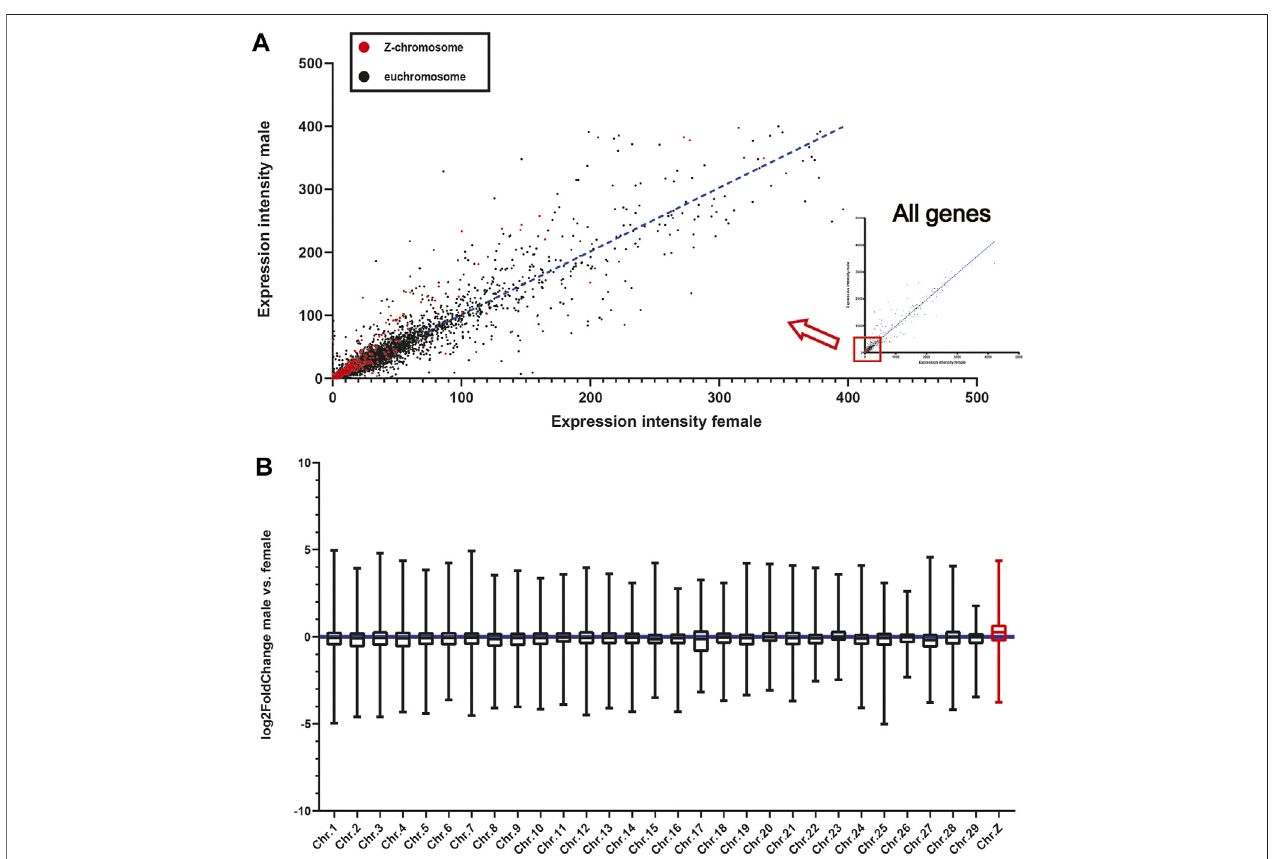
FIGURE 4 | The expression patterns of Z-chromosome-linked and Autosome-linked genes in mallards. (A) The expression levels of individual Z-chromosome- linked and euchromosome-linked genes. Each point in the scatter diagram represents the FPKM value of a gene in the male and female head samples. (B) Box plots showingthemedianlog 2 -foldchangevaluesperchromosomeofmalevs.female.Thewhiskersextendtotheminimumandmaximumvalueswithoutoutliers(alog 2 fold- change de fi nes outliers > fi ve or < −